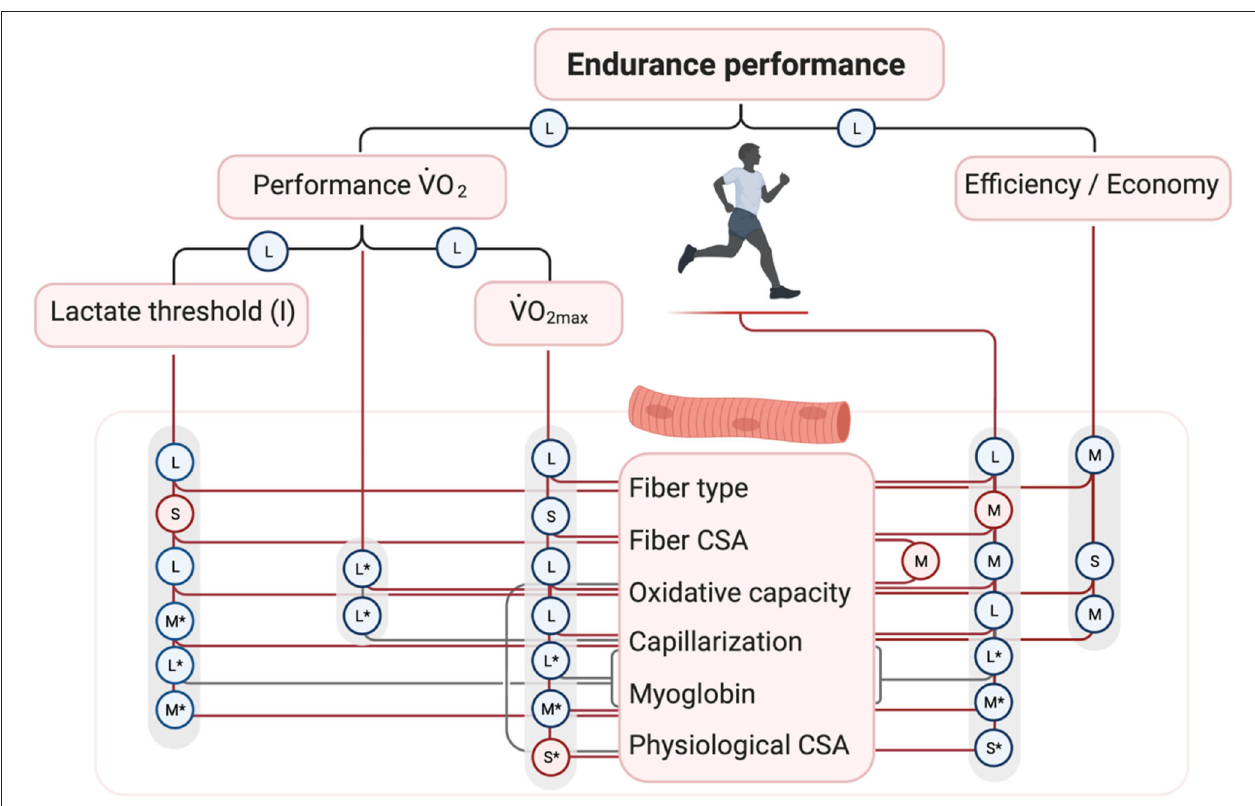
FIGURE 2 | Overall schematic describing the underlying skeletal muscle determinants of endurance performance and whole-body determinants of endurance performance. The schematic advances on the theoretical framework by Joyner and Coyle (2008). Based on a meta-analysis of the existing literature, effect sizes of correlations between these determinants and endurance performance have been summarized in forest plots (see Supplementary Material ). Random effect sizes were calculated based on Fisher’s z transformation of correlations and with between-study variance estimations based on the “more conservative” Sidik-Jonkman estimator. Effect sizes were interpreted in accordance with Cohen (1992): negligible ( r < 0.1), small ( r = 0.1–0.29), medium ( r = 0.3–0.5), and large ( r > 0.5), and indicated with the symbols N, S, M, and L, respectively. Negative effects are shown in red circles, positive effects in blue circles. Black lines indicate effects of single whole-body determinants, red lines indicate effects of single muscle determinants and gray lines indicate integrative effects of multiple muscle determinants. *indicates that limited research is available (i.e., only 1 or 2 studies). Studies included in the meta-analysis: Hoppeler et al. (1973), Booth and Narahara (1974), Hultén et al. (1975), Costill et al. (1976), Bergh et al. (1978), Foster et al. (1978), Ingjer (1978), Rusko et al. (1978, 1980), Ivy et al. (1980a,b), Gregor et al. (1981), Inbar et al. (1981), Komi et al. (1981) , Nygaard (1981), Zumstein et al. (1983), Coyle et al. (1984, 1988, 1992), Lortie et al. (1985), Neary et al. (1992, 2003), Farrell et al. (1993), Horowitz et al. (1994), Tonkonogi and Sahlin (1997), Dawson et al. (1998), Bishop et al. (2000), Passfield and Doust (2000), Hansen et al. (2002), Bentley and McNaughton (2003), Lucía et al. (2004), Mogensen et al. (2006), Baldari et al. (2007), Farina et al. (2007), Hansen and Sjøgaard (2007), Flynn et al. (2009), Iaia et al. (2009), Suriano et al. (2010), Jacobs et al. (2011), Kohn et al. (2011), Hopker et al. (2013), Jacobs and Lundby (2013), Støren et al. (2013), Hunter et al. (2015), Gifford et al. (2016), van der Zwaard et al. (2016a, 2018b), Vikmoen et al. (2016), Lundby et al. (2017), Cardinale et al. (2018), Dandanell et al. (2018), Mitchell et al. (2018), Batterson et al. (2020), Kovács et al.